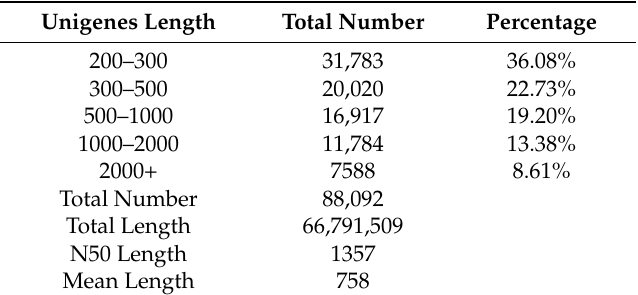
Table 2. Unigenes Quantity and Percentage of Length.